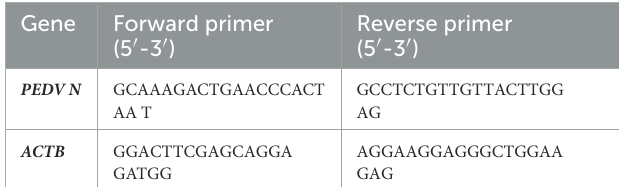
TABLE 1 Primer used in the RT-qPCR